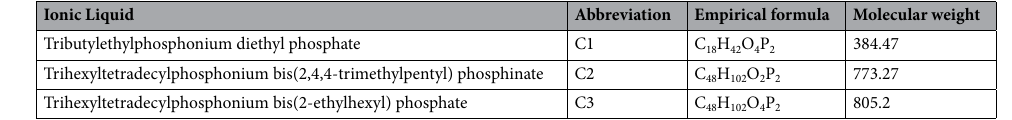
Table 1. Phosphonium ionic